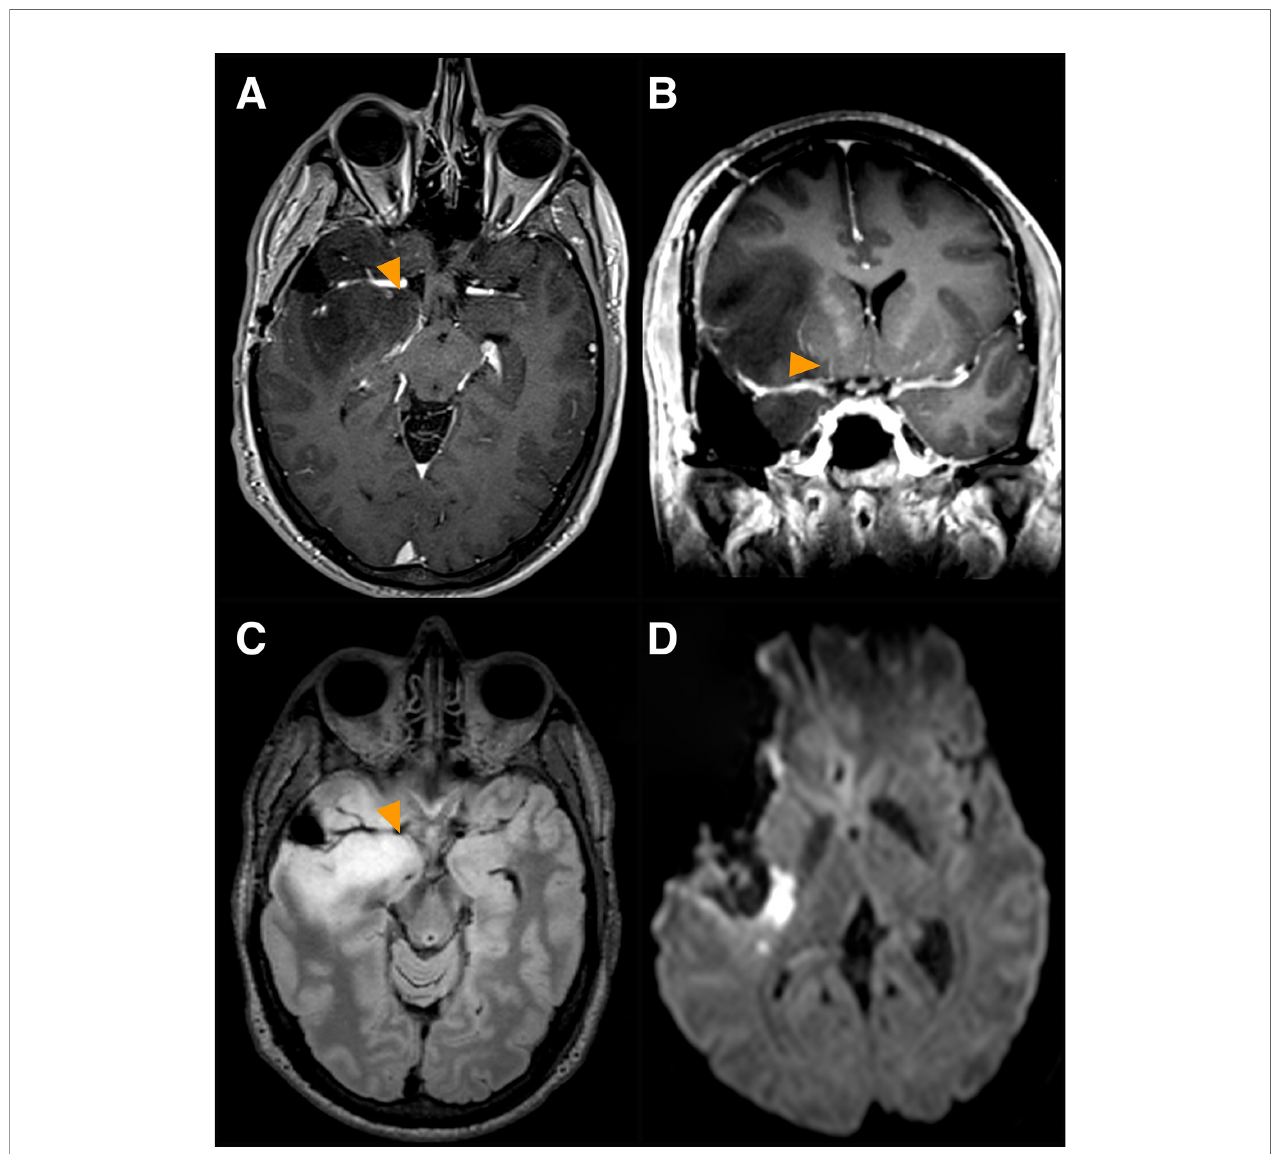
FIGURE 3 | Involvement of other deep perforators. A case of a dominant fronto-tempo-insular low-grade glioma is presented. (A, B) Pre-op axial (A) and coronal (B) volumetric 3T MR T1 post-Gadolinium images displaying tumor involvement of other deep perforators ( yellow arrows ), arterial branches originating at the origin of the anterior choroidal artery from the internal carotid artery, medial to the LSA complex arteries. (C) corresponding pre-op axial FLAIR image. (D) post-op DW axial image, displaying ischemia posteriorly to the surgical cavity at the level of the posterior limb of the internal capsule. Severe MEP fl uctuations and signi fi cant reduction occurred at the end of the resection. SEPs were unchanged. Arterial pressure was increased. The patient woke up with severe upper and lower limb paresis, which recovered progressively and entirely within 3 months after